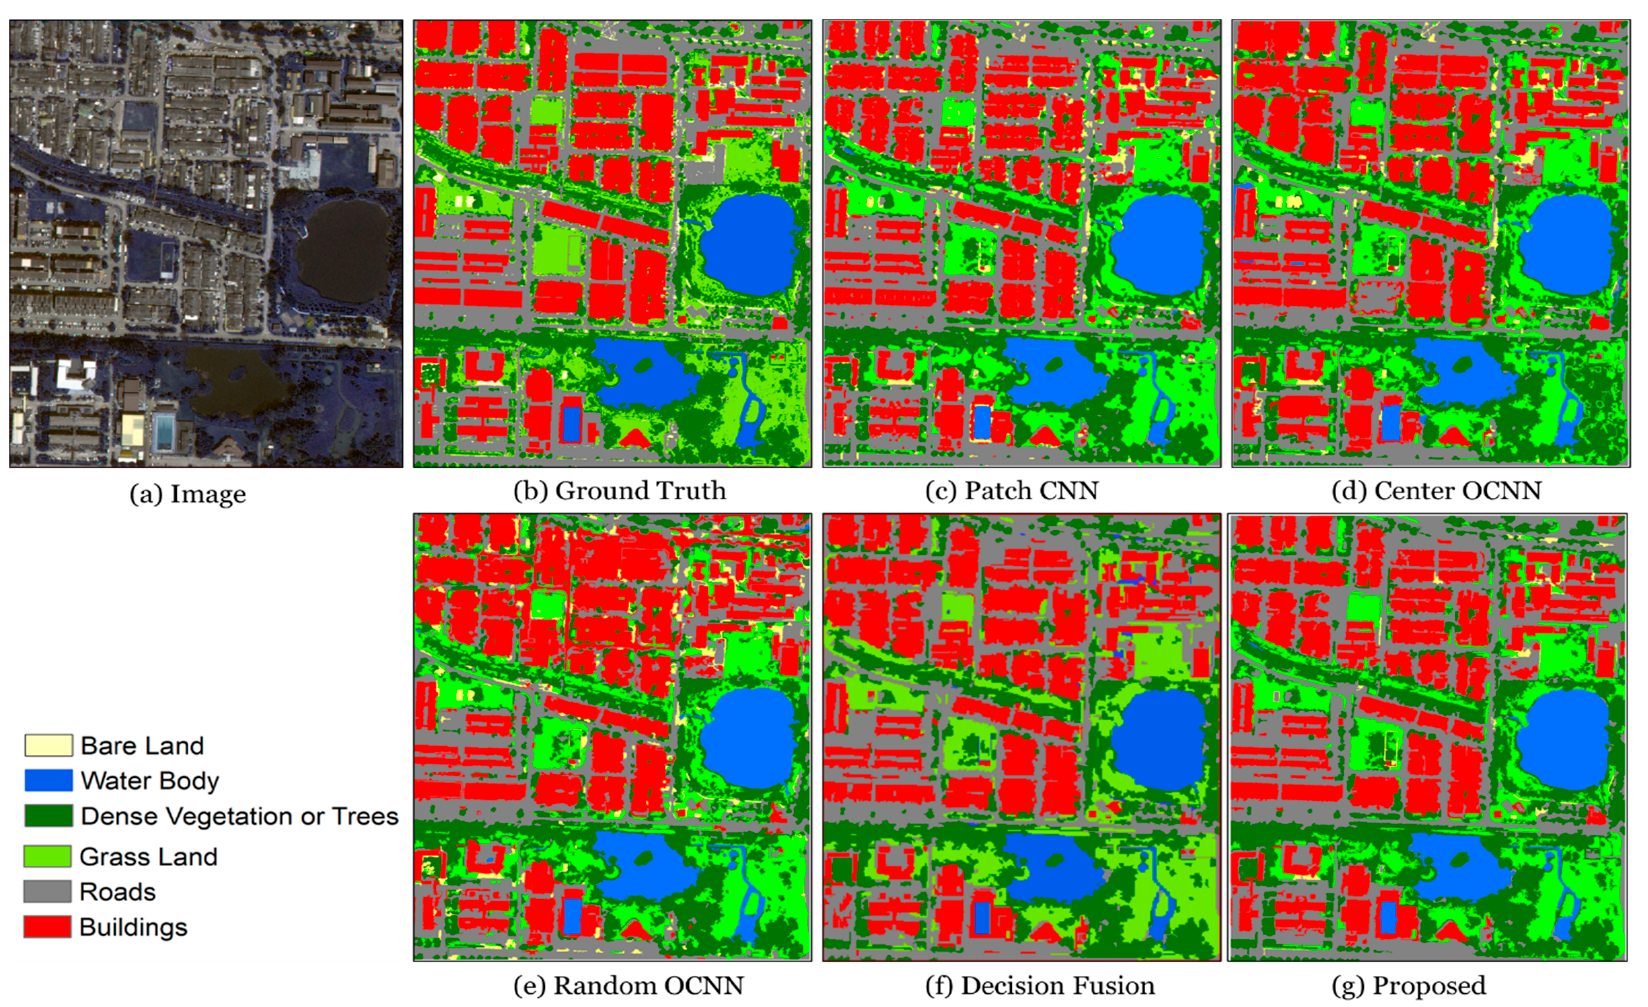
Figure 10. Classification maps of different methods used in this research for the training area.